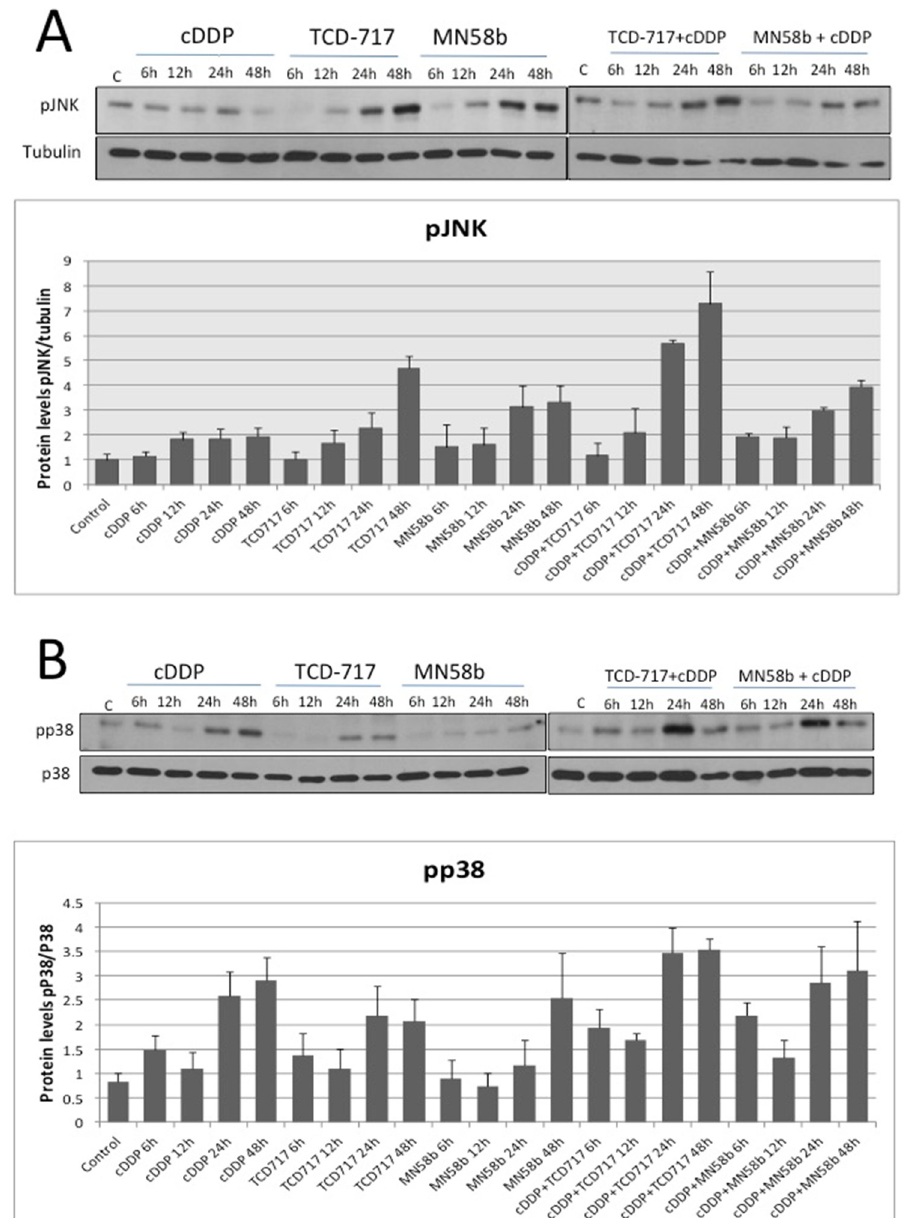
Figure 3. MAPK pathway activation in response to treatment with cisplatin combined with ChoK α inhibitors. H460 human NSCLC cells were exposed to cisplatin, ChoK α inhibitors, or both treatments following a sequential schedule and showing a synergistic effect (cisplatin followed by ChoK α inhibitors). p-JNK ( A ) and p-p38 ( B ) levels were analyzed by Western blotting at different timepoints. Tubulin or total p38 protein were used to normalize. Results are the means of three independent experiments. Western blots are representative of one single experiment.